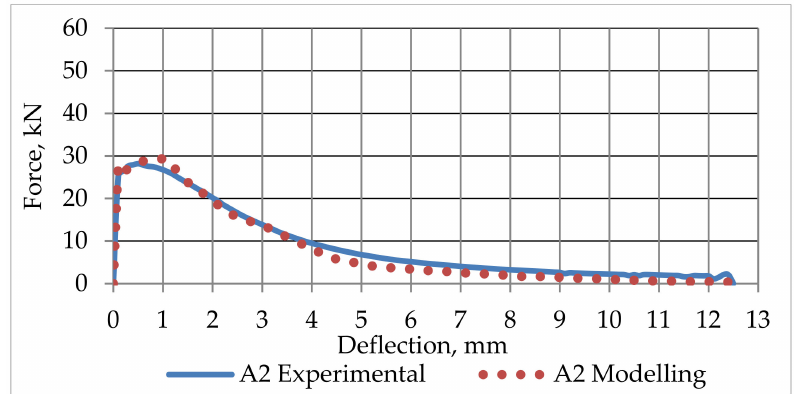
Figure 28. Experimental and modelling graphs for Group A2.